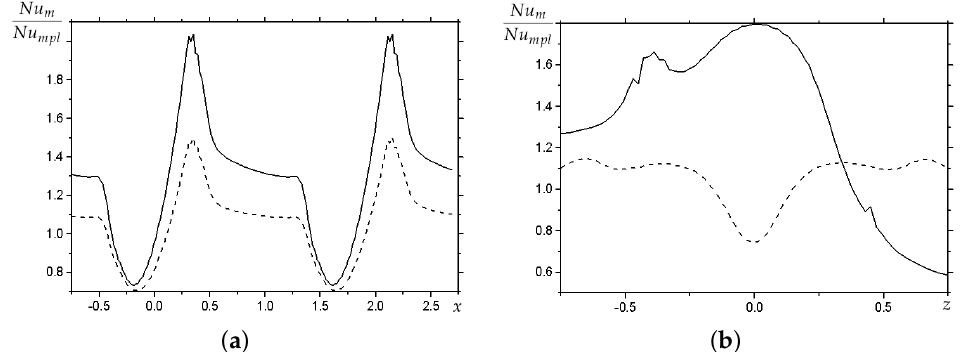
Figure 14. Comparison of band-averaged distributions with spherical dimples of relative Nu ( x ) ( a ) and Nu ( z ) ( b ). Solid lines are dimples without displacement, and dashed lines are with a displace- ment of 0.25 from the longitudinal axis.